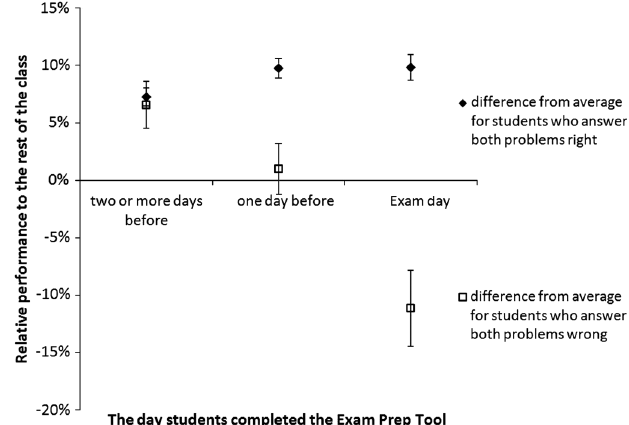
FIG. 4. Thirteen of the questions given on the exam were matched with 13 of the paired problems on the exam-prep tool. Students that got both practice problems correct scored 15% higher on the matched problem on average than students that got both practice problems wrong.